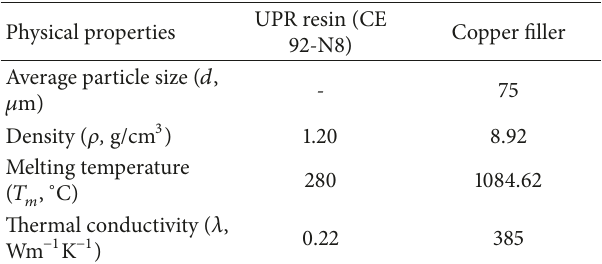
Table 2: Component physical properties of composite (matrix and filler)